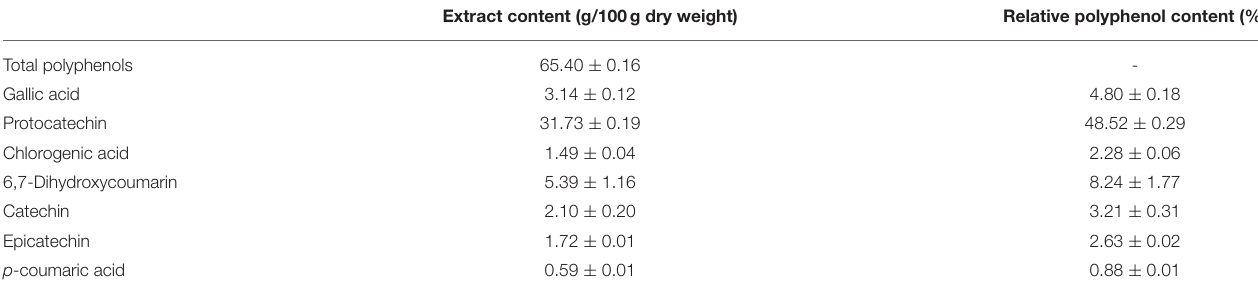
TABLE 1 | Chemical characterization of